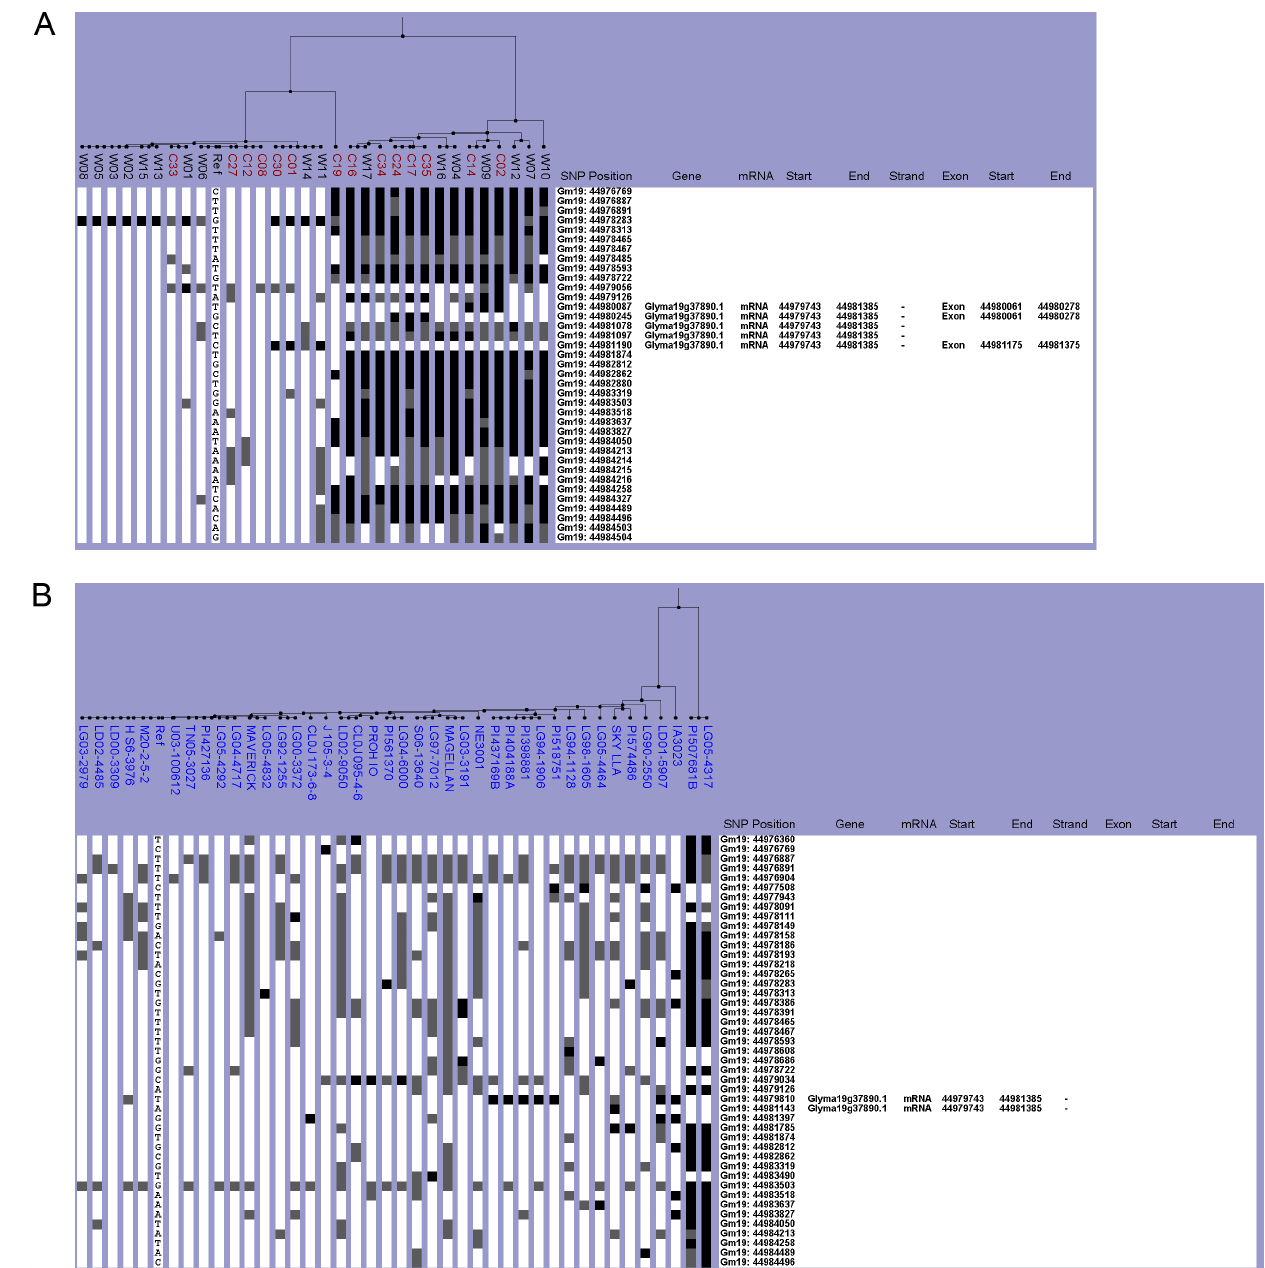
Figure 6. Haplotype analysis of the Dt1 gene region. The SNPViz clustering pictorial displayed the SNPs in an 8.6-kb region on chromosome 19, which included Glyma19g37890. Nucleotide polymorphisms were examined in A) the wild (black) and cultivated (red) lines from the Chinese collection and B) the NAM parents (blue). Details about the SNPViz clustering pictorial were described in the Figure 1 legend. doi:10.1371/journal.pone.0094150.g006 lines from the cultivated Glycine max lines. Within each major group, the lines were also separated into subgroups that further revealed haplotype diversity.